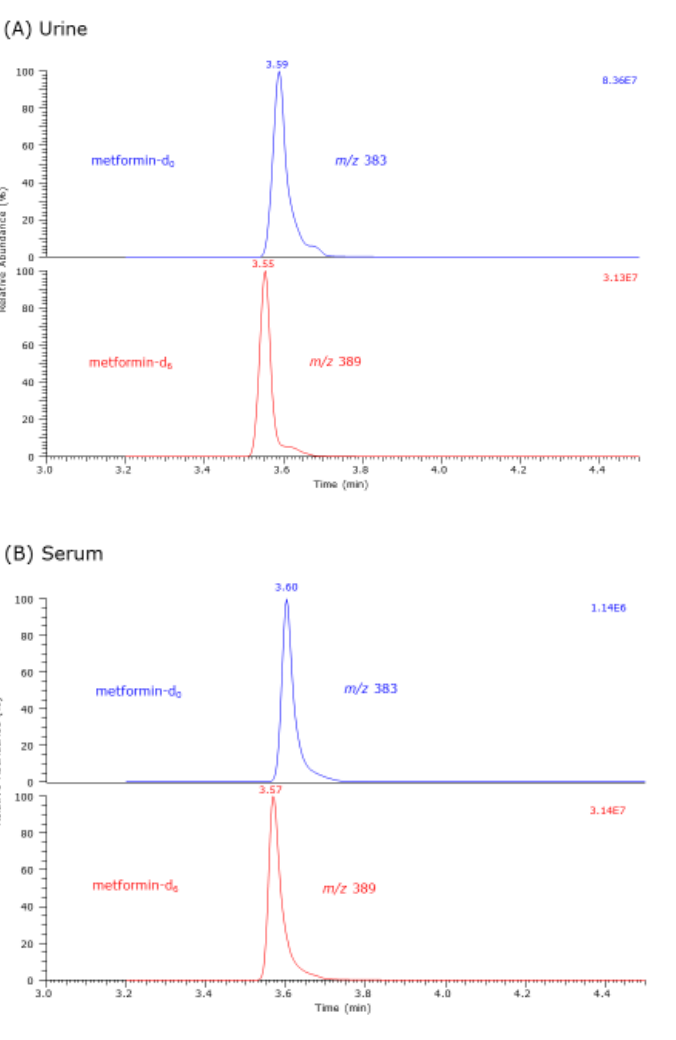
Figure 4. Partial GC–MS chromatograms from the quantitative analysis of metformin in ( A ) urine and ( B ) serum samples of Becker muscular dystrophy (BMD) patients. Selected ion monitoring of m/z 383 for metformin (metformin-d 0 ) and m/z 389 for the internal standard (metformin-d 6 ). The concentration of metformin-d 6 was 100 µM in the urine and 20 µM in the serum sample.